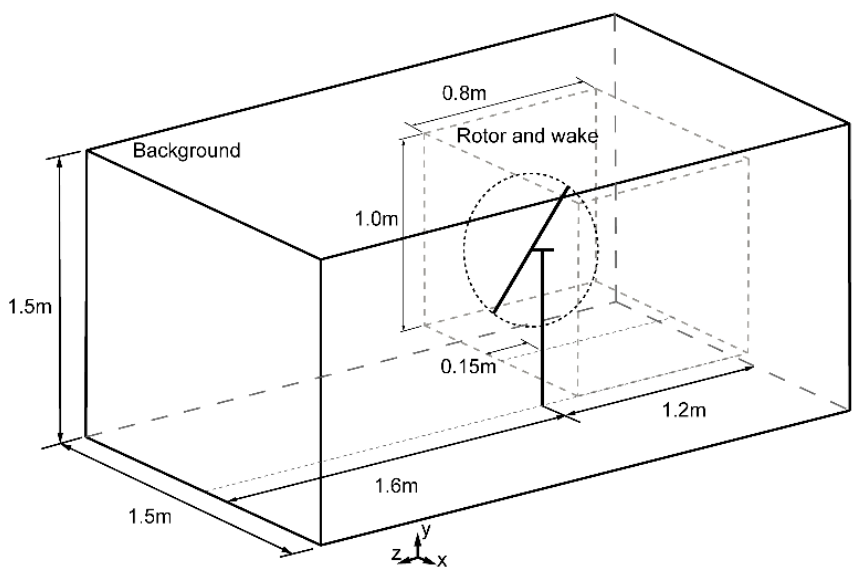
Figure 2. The calculation domain.